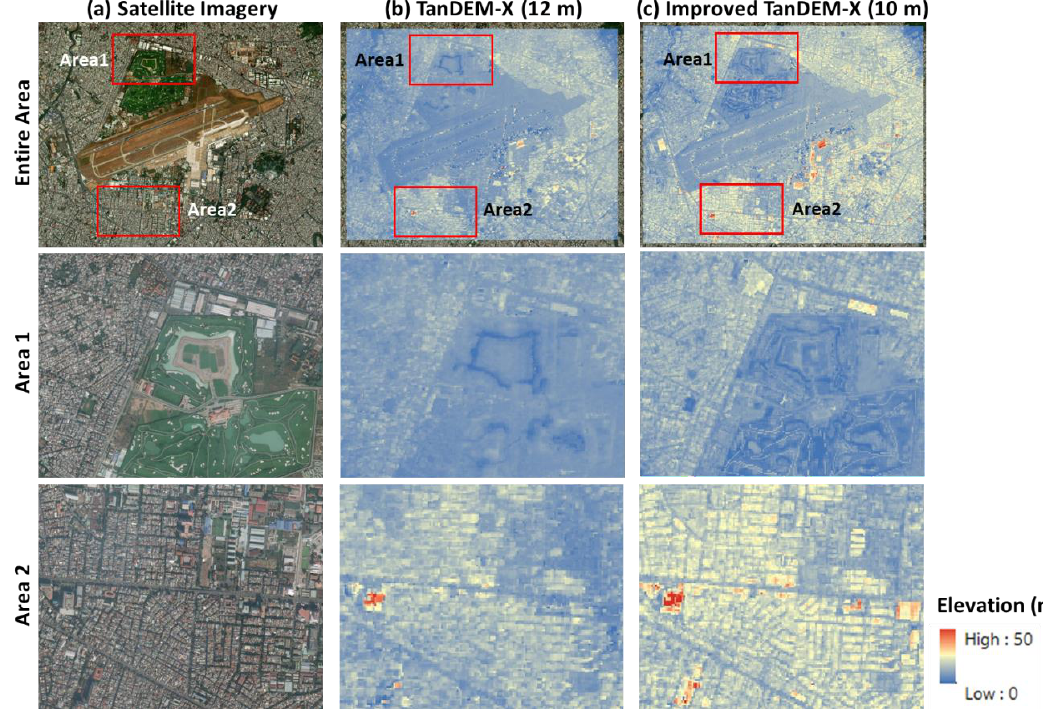
Figure 8. Visual assessment of iTanDEM-X in Ho Chi Minh City, Vietnam: ( a ) Satellite Imagery, ( b )TanDEM-X (12 m), ( c ) improved TanDEM (10 m) .